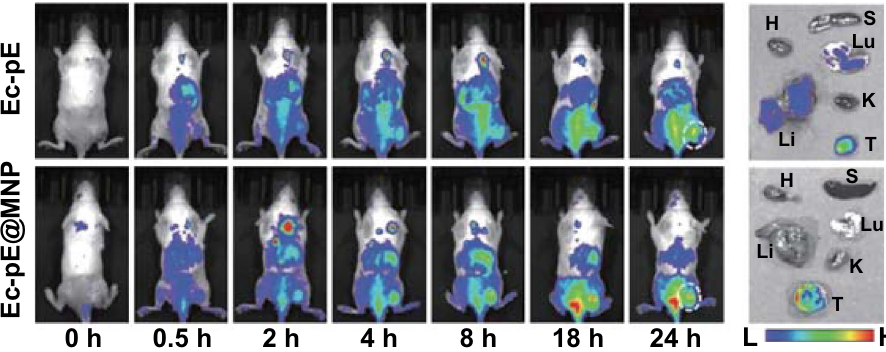
Fig. 5 Optical images of 4T1 tumor-bearing mice and major organs after intravenous injection of E. coli MG1655 with NDH-2 enzyme overex- pressed (Ec-pE) and Fe 3 O 4 nanoparticles decorated Ec-pE. Reprinted with permission from Ref. [63]